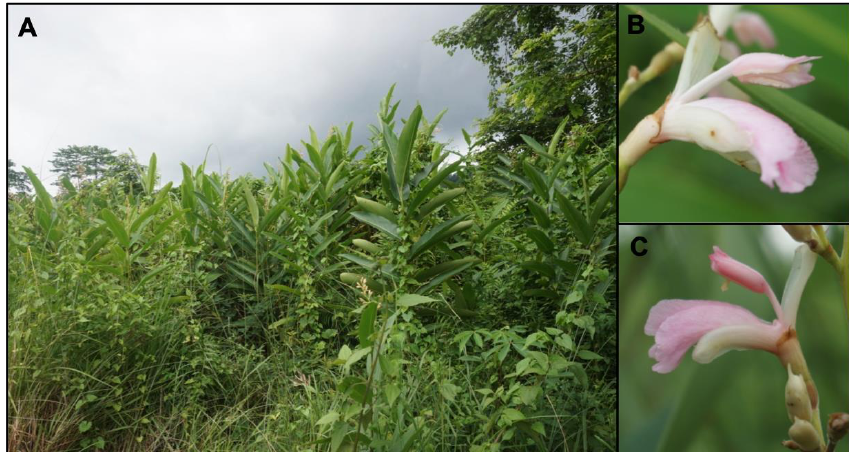
Figure 2. Habitat and floral details of Alpinia nigra at Pakke Tiger Reserve, Arunachal Pradesh, India. ( A ) Population of Alpinia nigra at Pakke Tiger Reserve, ( B ) cataflexistylous (protandrous) morph (picture taken at 08:45 h) and ( C ) anaflexistylous (protogynous) morph (picture taken at 09:40 h).